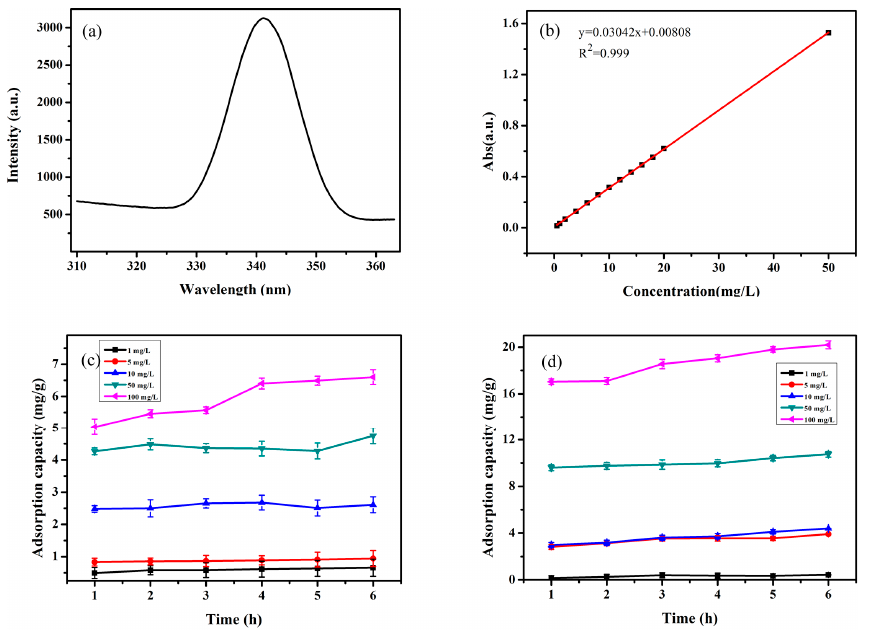
Figure 3. Adsorption experiments. ( a ) The UV adsorption of TC; ( b ) The linear range of TC; ( c ) The adsorption capacity of 500 nm PS-MPs to TC (1, 5, 10, 50, 100 mg/L); ( d ) The adsorption capacity of 60 nm PS-NPs to TC (1, 5, 10, 50, 100 mg/L).